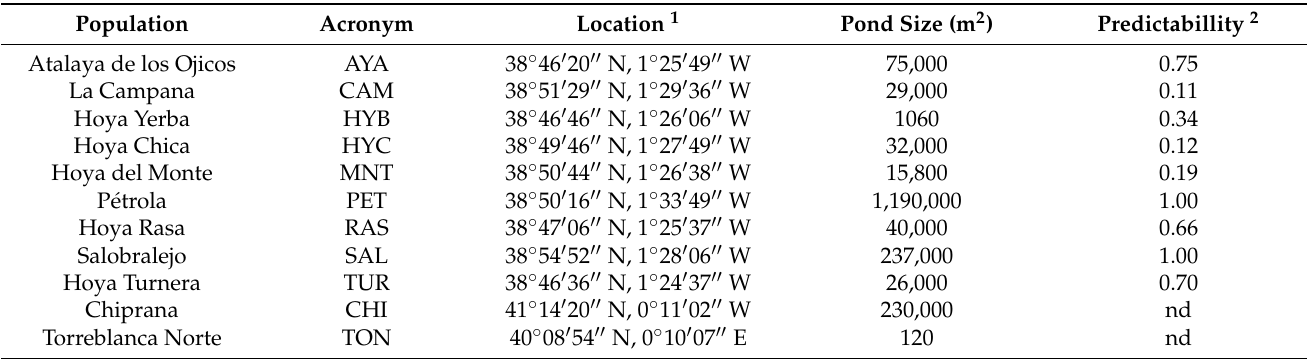
Table 1. Populations included in the study, location and their estimated degree of predictability of the hydroperiod length in a year based on [18]. (nd: data not available).